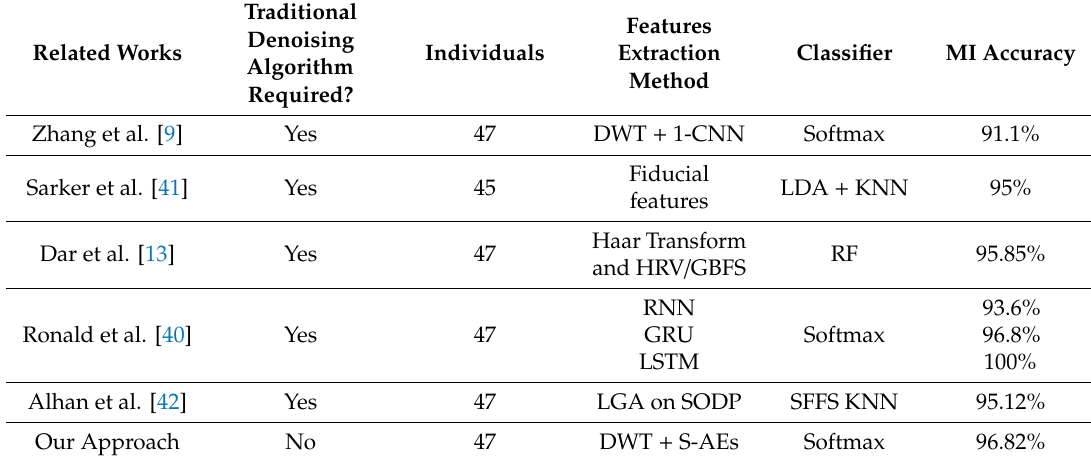
Table 5. Comparison with existing literature on ECG biometric identification using the MIT-BIH-AHA.